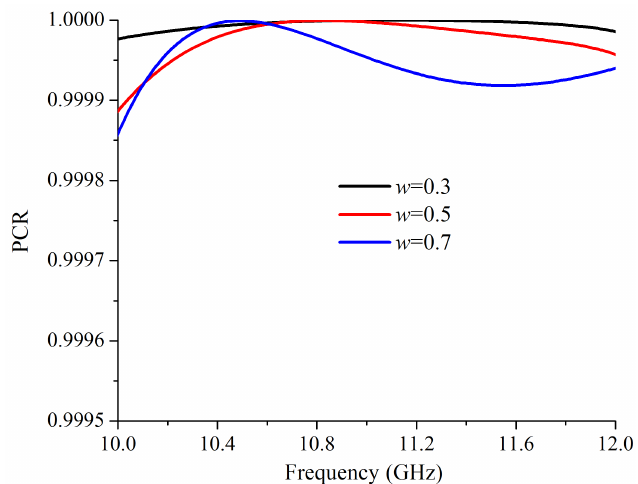
Figure 7. The simulated polarization conversion ratios with different w